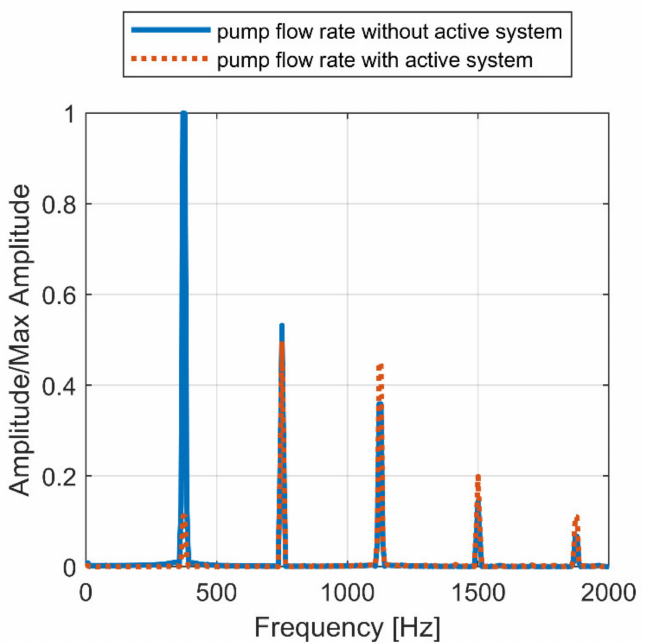
Figure 11. Simulation cycle 1, section 1: flow ripple FFT at 250 bar, 2500 rpm, 100% swash plate